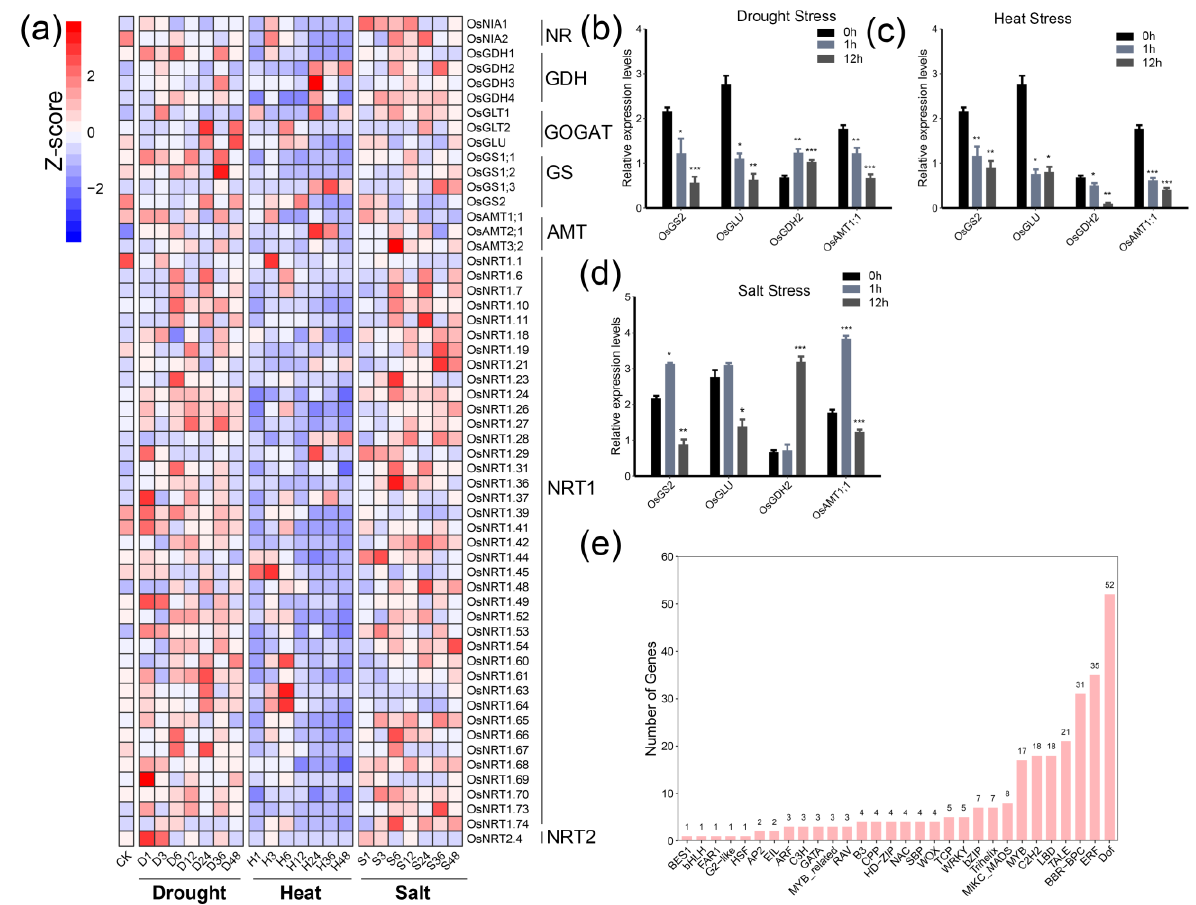
Figure 7. The diversification of NM genes under abiotic stresses. ( a ) shows the expression of all NM genes under three abiotic stresses, including drought stress, heat stress, and salt stress. The genes with average FPKM < 1 were filtered. ( b ), ( c ) and ( d ) indicate the relative expression of four genes, including OsGS2 , OsGLU , OsGDH2 , and OsAMT1;1 , by qRT-PCR validation. The bar “0 h” means the control. The bar “1 h” means 1 h after treatment, while “12 h” means 12 h after treatment, and ( e ) indicates transcription factors binding site on the promoter (2000 bp before the transcript start sites) predicted by PlantTFDB. “* ” indicates p < 0.05, “**” indicates p < 0.01, while “***” indicates p < 0.001.